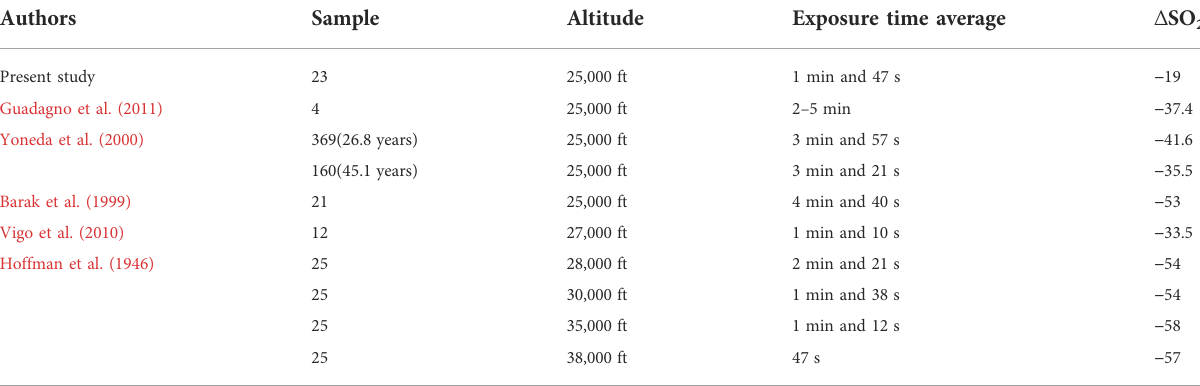
TABLE 5 Relationship between altitude and average time of exposure to HH and SO 2